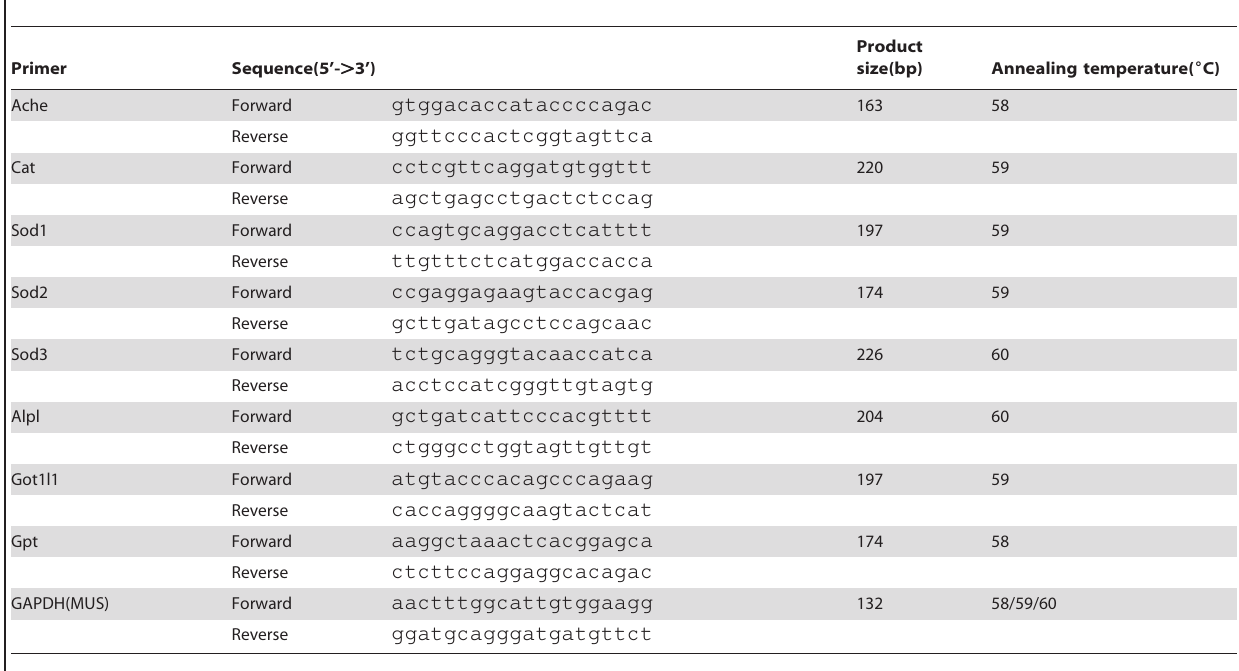
Table 1. Primers used for Real-Time PCR analysis of indicated enzyme transcripts in liver cells.